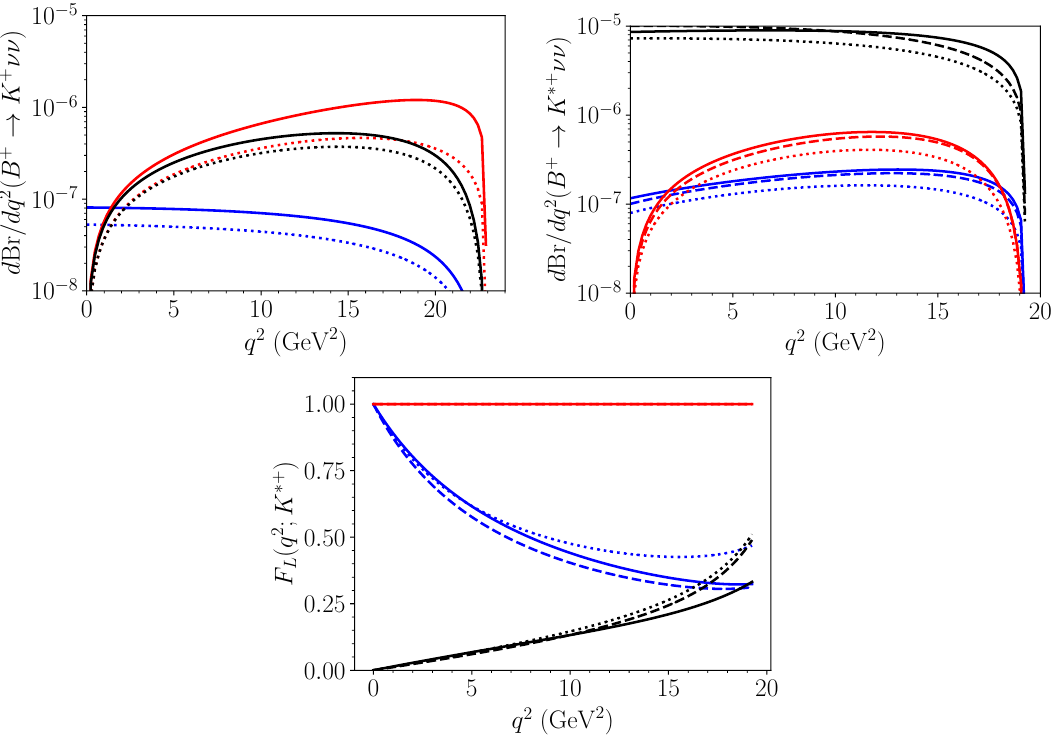
Figure 1 . The differential branching ratio distributions (top) and the differential longitudinal polarisation fraction F L (bottom) generated for different non-zero Wilson coefficients C XLL 0 . 01 TeV − 2 for X = V,S,T, and choices of form factors. The blue (red) [black] lines stand for the vector (scalar) [tensor] operator, respectively. The solid lines denote the results for the form factors which are used in the analysis, taken from [36] for the B → K ∗ and from [35] for the B → K form factors. Both sets of form factors are based on a combined fit to LCSR and LQCD data. The dotted lines indicate the form factors based on the LCSR fit in [35] and the dashed lines show the B → K ∗ form factors obtained using a combined fit to LCSR and LQCD in [35]. Note that no SM contribution is included